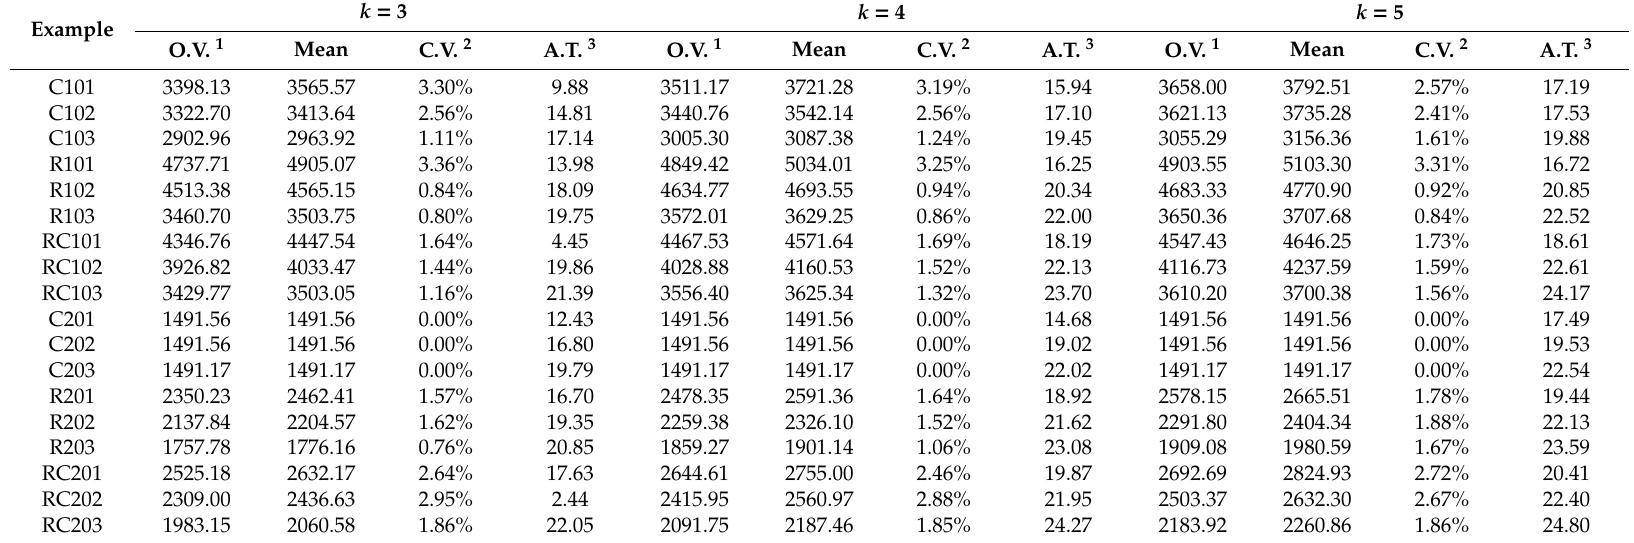
Table 12. Performance of the algorithm when the skill number k is equal to 3, 4, and 5,